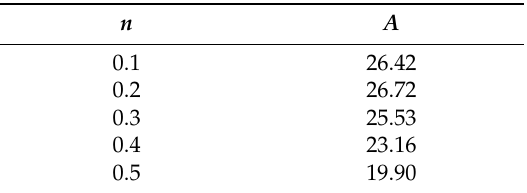
Table 2. Values of constant A ( c D = A /Re) for the calculation of the drag coefficient for flow normal to a circular cylinder, for Re ≤ 0.1 and n ≤